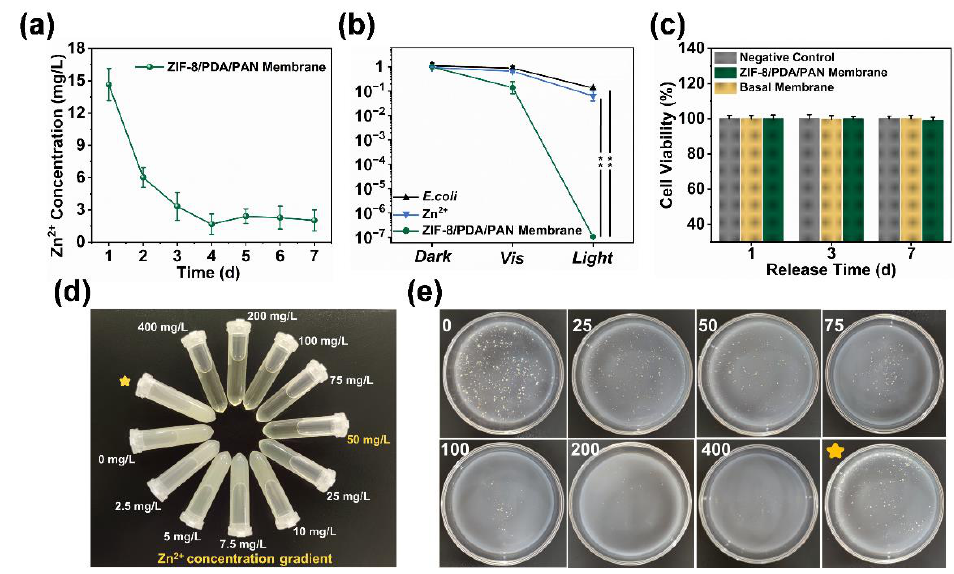
Figure 8. ( a ) Release concentrations of Zn 2+ in the ZIF – 8/PDA/PAN composite membrane over 7 days; ( b ) under different conditions, the killing effects of Zn 2+ and the ZIF – 8/PDA/PAN composite membrane on E. coli ( n = 3, ** p < 0.01); ( c ) the effects of different Zn 2+ concentrations on L929 cell activity; ( d ) camera pictures of Zn 2+ with different concentrations; ( e ) photographs for the killing effects of different Zn 2+ concentrations on E. coli (the yellow star was the experimental extract concentration; the Zn 2+ minimum inhibitory concentration labeled yellow).